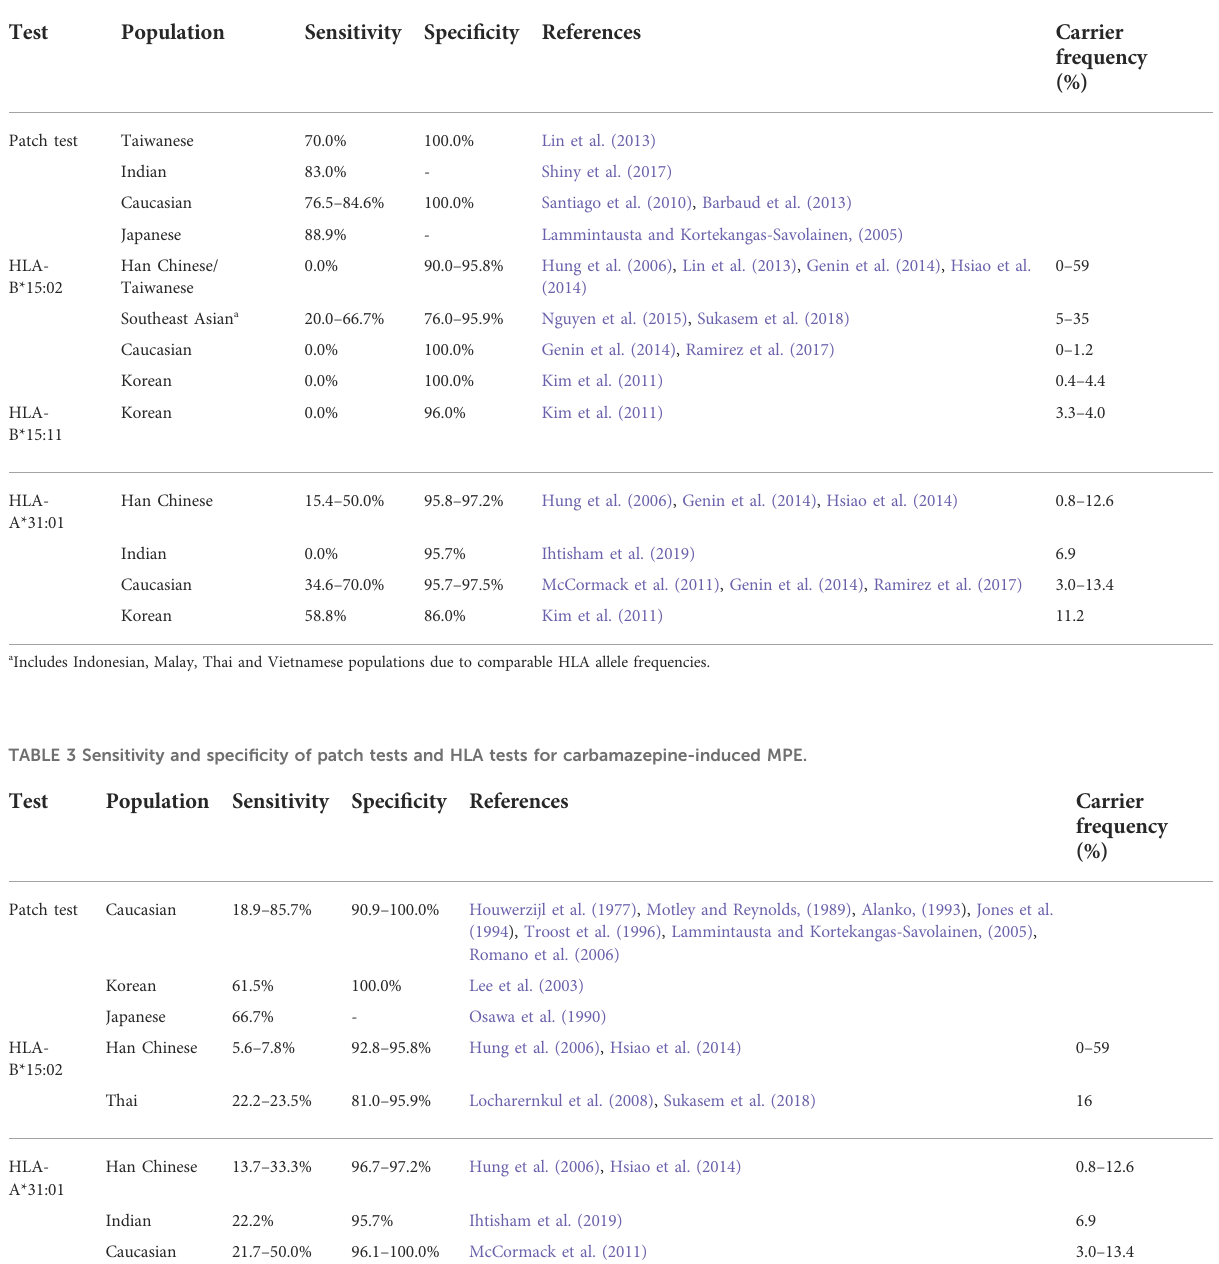
TABLE 2 Sensitivity and speci fi city of patch tests and HLA tests for carbamazepine-induced DRESS.